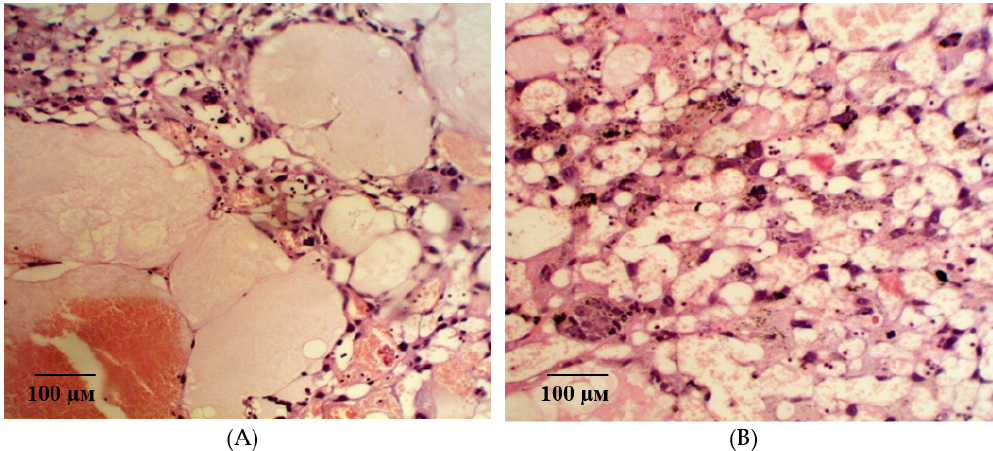
Figure 7. Microphotographs of the fetal placenta structures in control animals on the 21st day of gestation in simulated ADMA-like preeclampsia. Note: the area of the interstitial space is smaller compared to intact animals ( A ). Interstitial edema of small vessels and stroma of the villi. Local fibrin deposition. Hofbauer cells ( B ) are well visualized. Hematoxylin and eosin staining. Magnification: 200× ( А , B ).